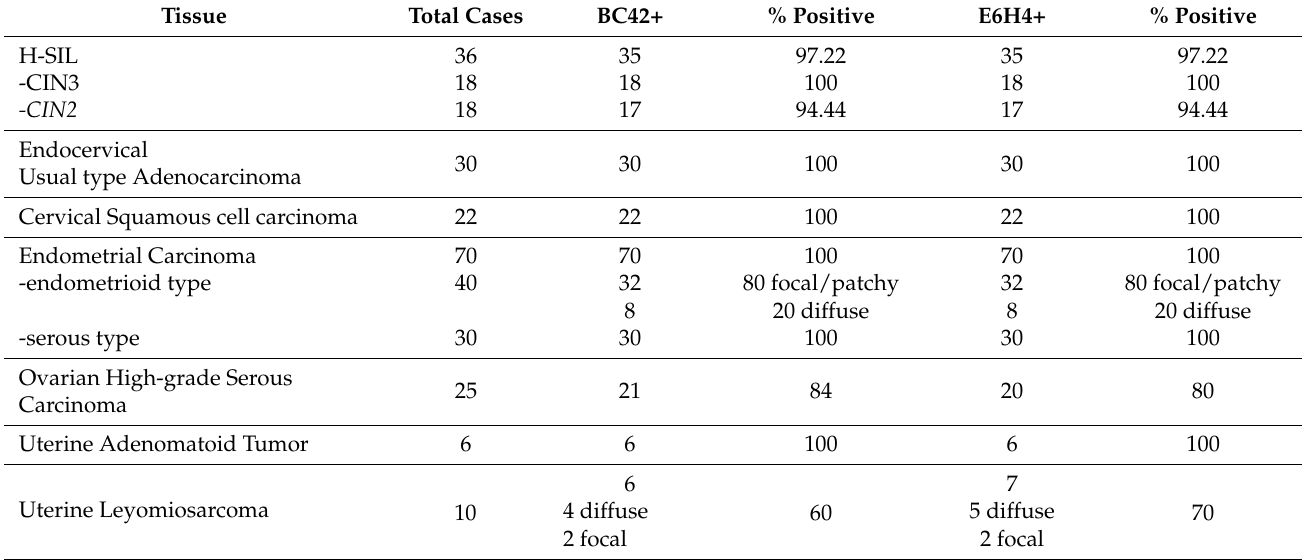
Table 1. BC42 and E6H4 comparison staining across all gynecological neoplasms tested.